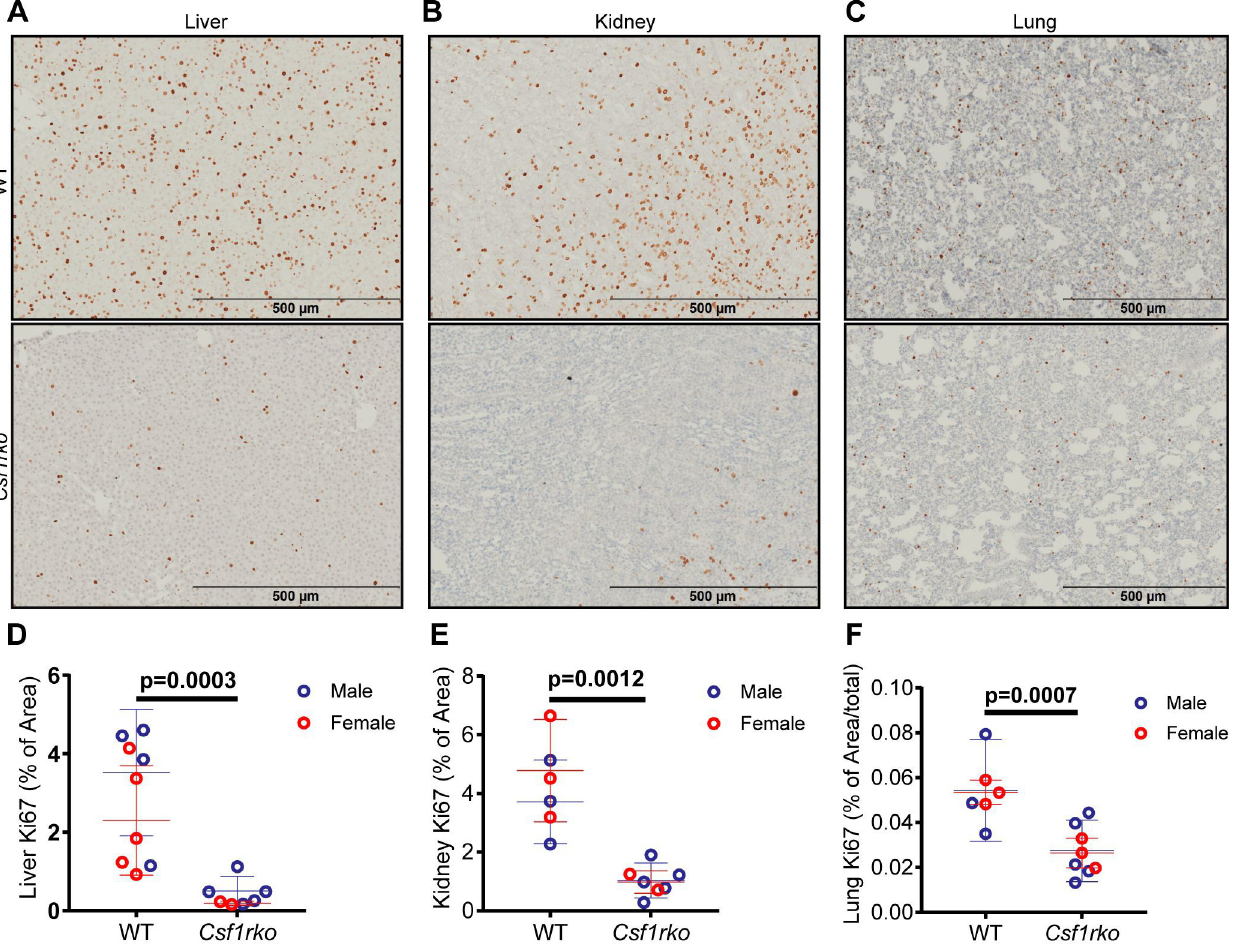
Fig 2. Detection of Ki67 + proliferating cells in the liver, kidney and lung of WT and Csf1rko rats at 3 wks of age. (A-C) Representative images of Ki67 staining in (A) liver, (B) kidney and (C) lung of WT and Csf1rko rats. D-F) Quantitative analysis of Ki67+ cells in (D) liver, (E) kidney and (F) lung. n � 6 per genotype, graphs shows the mean ± SD, genotype comparisons were analysed by Mann Whitney test.